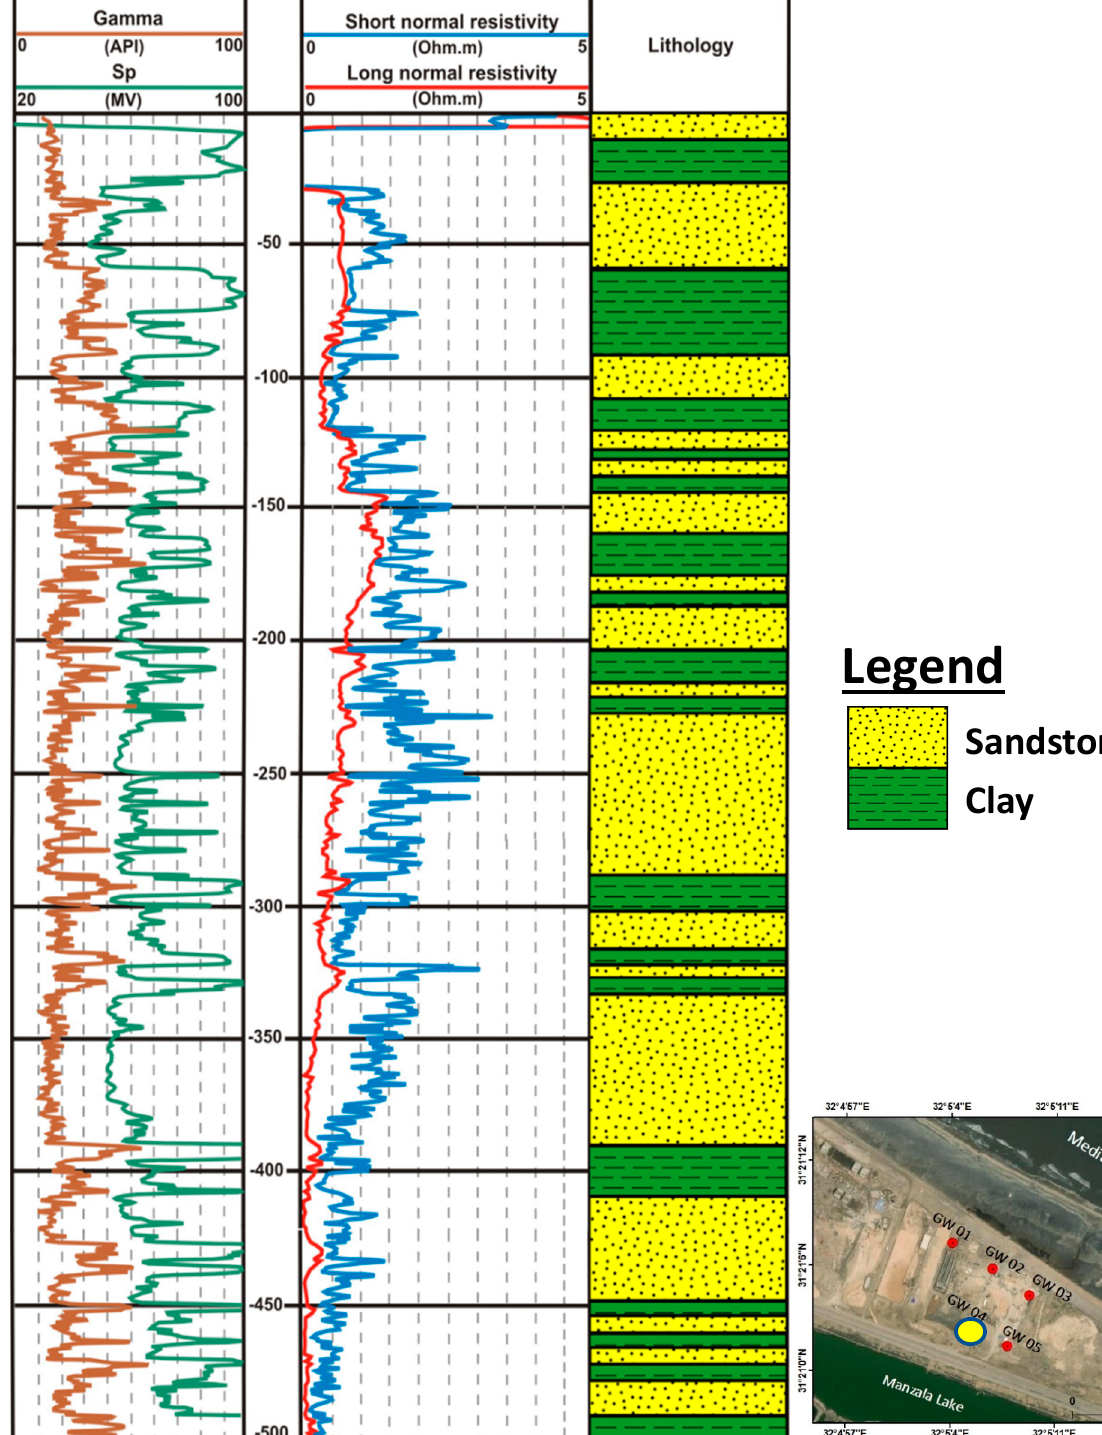
Figure 9. Gamma ray, SP, resistivity logs and the corresponding lithology in well GW04.